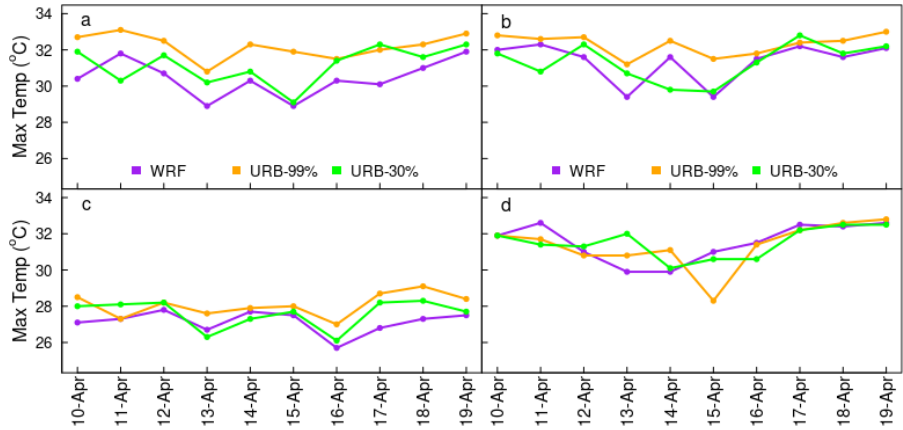
Figure 9. Daily maximum near-surface (2 m) air temperature for current LULC, high-urbanization (URB_99%), and low-urbanization (URB_30%) scenarios at ( a ) Dar, ( b ) Dar-Port, ( c ) Morogoro, and ( d ) Kibaha stations.